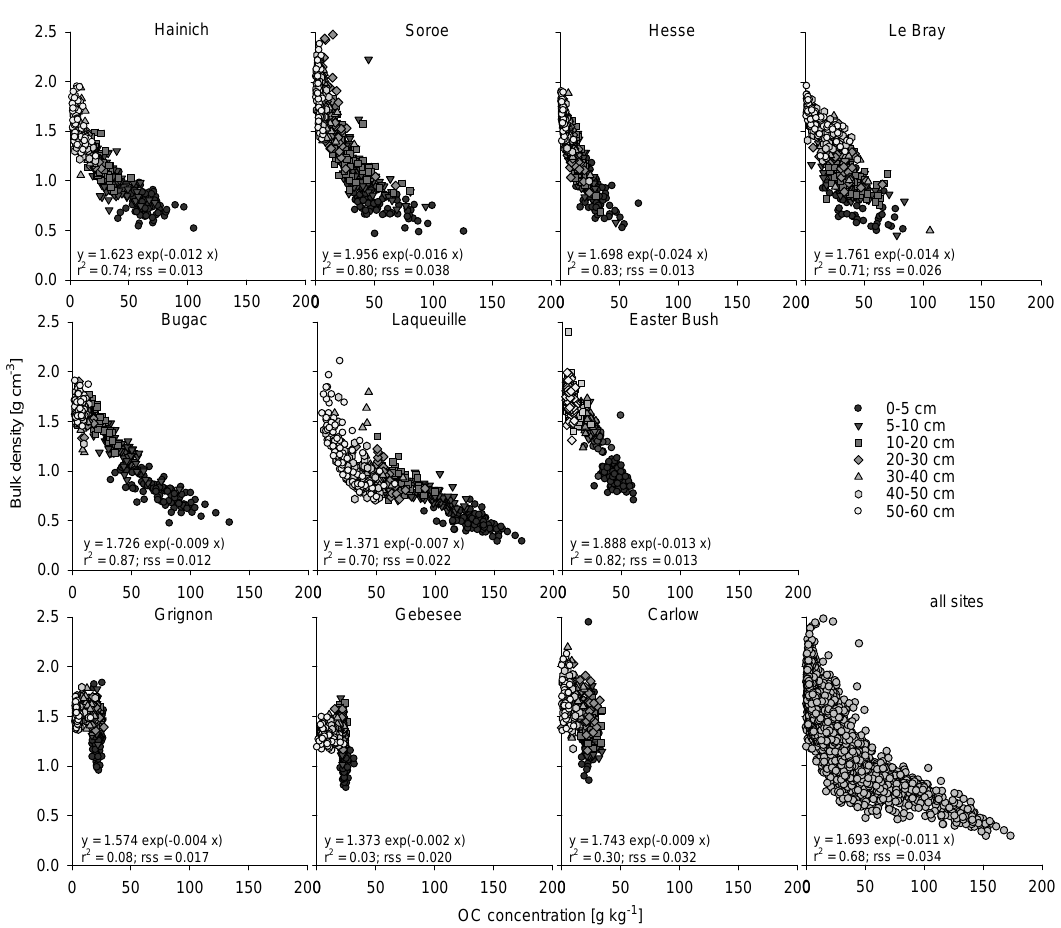
Fig. 4. Relation between OC concentration and bulk density (BD) at different sites and across all sites. Samples from all soil depths are included in the graphs. Equations are the result of a nonlinear regression analyses between OC concentrations and BD ( r 2 : coefficient of determination; rss: residual sum of squares).